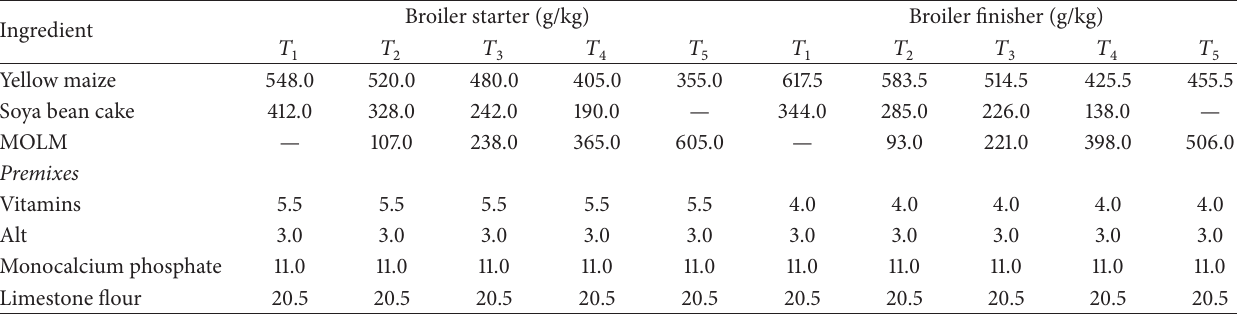
Table 2: Composition of broiler starter and finisher feed rations formulated with inclusion of MOLM.